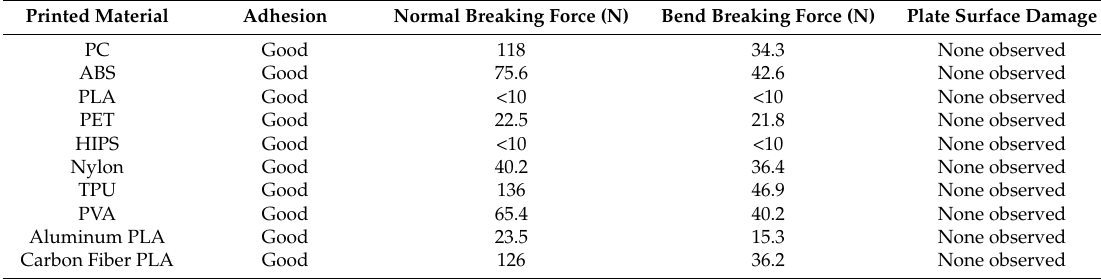
Table 5. Printing test results for CubeGlue ® -treated PC build